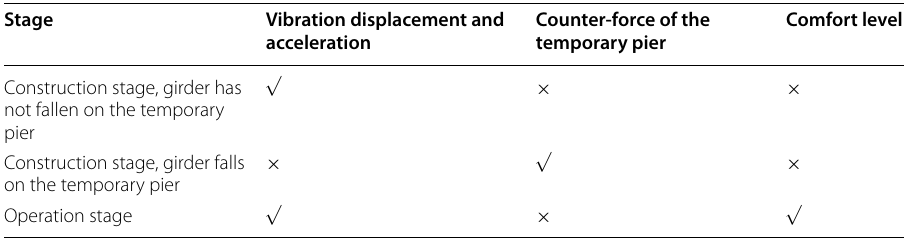
Table 5 Evaluation index of bridge dynamic response in each stage